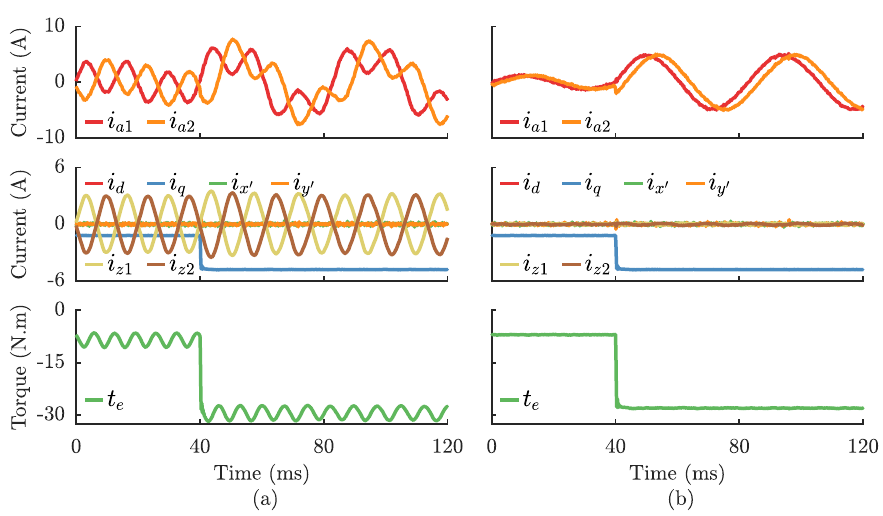
Figure 9. Experimental results for a step change in the q -axis current at 750 rpm, considering the six- phase drive operating under the proposed control strategy with the zero control stage: ( a ) disabled; ( b ) enabled.